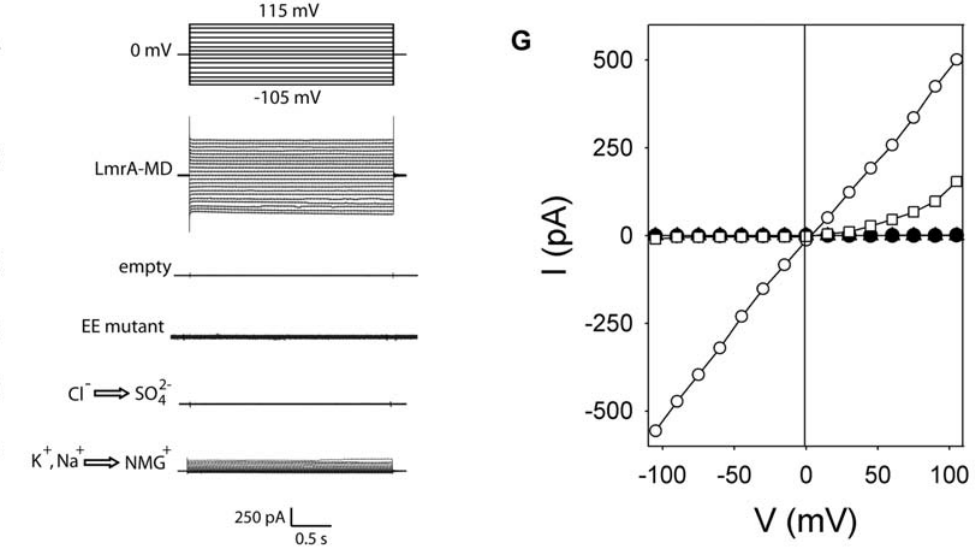
Figure 2. Electrophysiological analyses of ion transport in proteoliposomes by ‘dip-tip’ method. A, Voltage step protocol from a holding potential of 0 mV to various voltages (ranging from 2 105 mV to + 115 mV), back to 0 mV. B, C, D, Current traces for LmrA-MD (B) or empty liposomes without protein (C) or EE LmrA-MD (D) in the presence of 10 mM NaCl. E, F, Current traces for LmrA-MD in the presence of SO 42 2 instead of Cl 2 (E), or NMG + instead of Na + and K + (F). G, I–V curves from the traces in (B–F) ( # , LmrA-MD; K + /Na + by NMG + ; , , EE; n , empty liposomes; the latter two traces are hidden behind